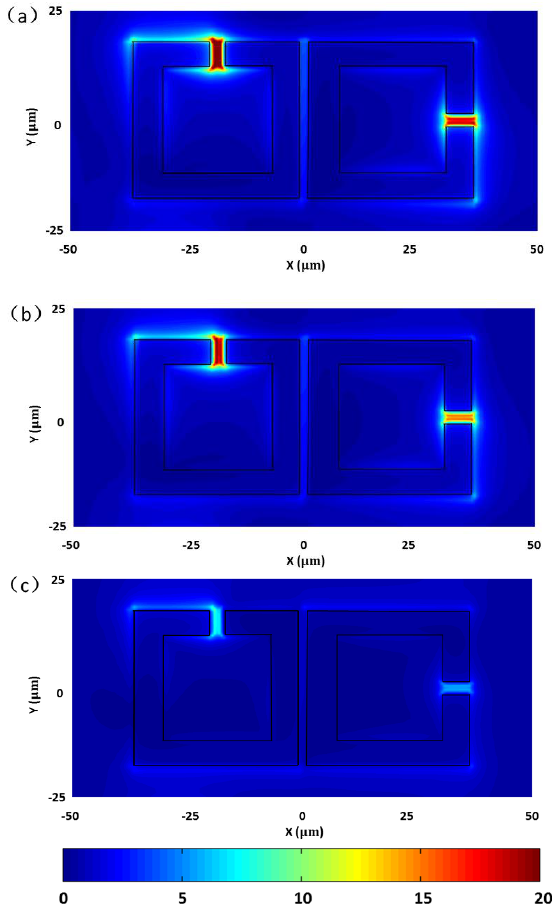
Figure 5. The distributions of electric field at the PIT resonance frequency for the cases of ( a ) without graphene; ( b ) 0.2 eV F E ; and ( c ) 0.8 eV F E .